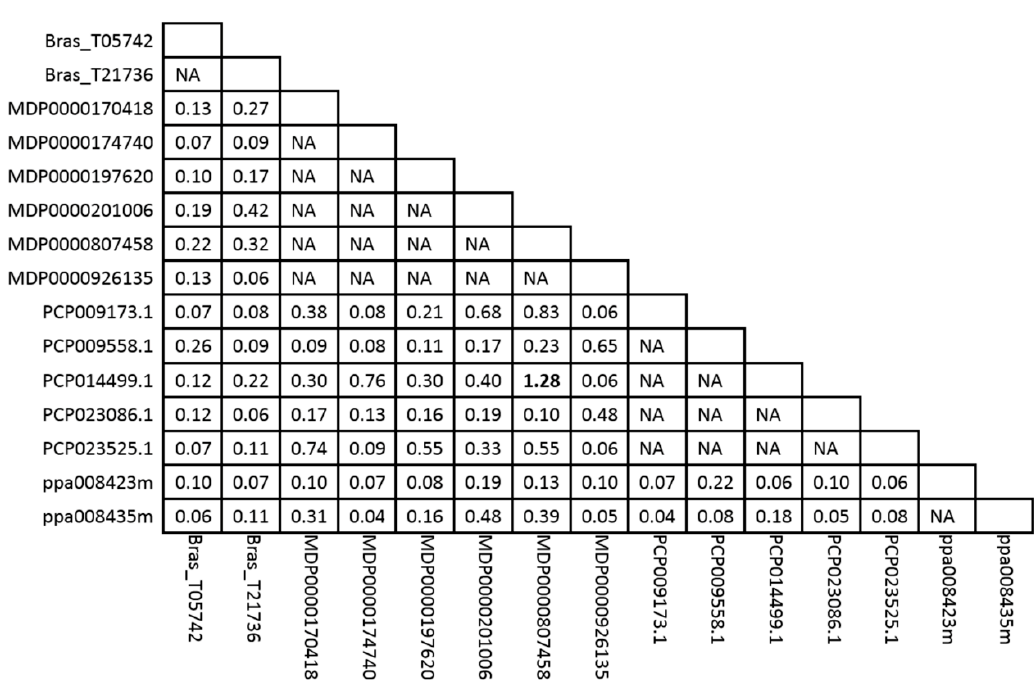
Figure 4. Estimation of ω values of MDH gene clade VI using the ML method. The ω value higher than one is highlighted in black bold. Table 2. Identification of putative cis element in the promoter of MDP0000807458 gene.